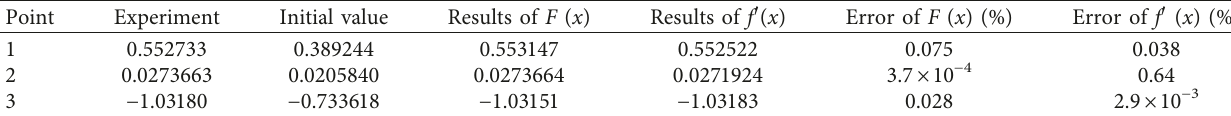
Table 6: Displacement of X direction of the observed points.